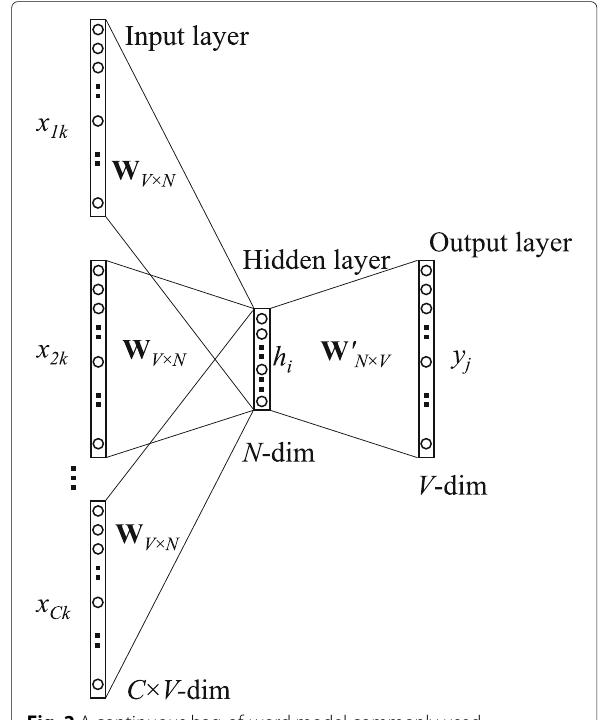
Fig. 2 A continuous bag-of-word model commonly